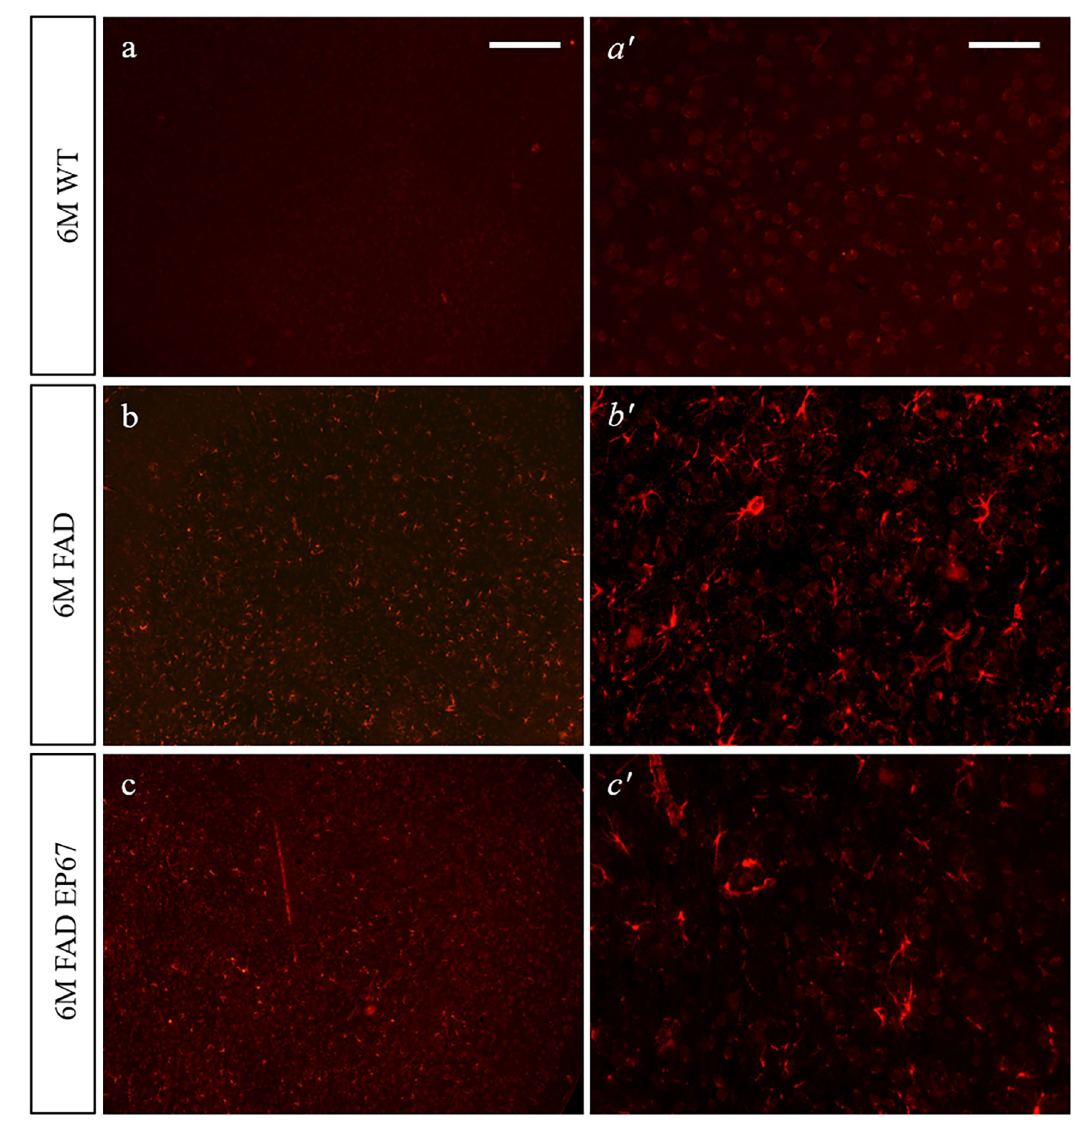
Fig 10. GFAP expression. Representative sagittal cortex sections from 6 month old wild type (a & a’ ), 5XFAD (b & b’ ) and 5XFAD EP67 treated (c & c’ ) mice sections were co-stained with an antibody against GFAP (-red- excitation λ : 358 emission λ :461). Scale bars: a-c 150 μ m, a’- c’ 75 μ